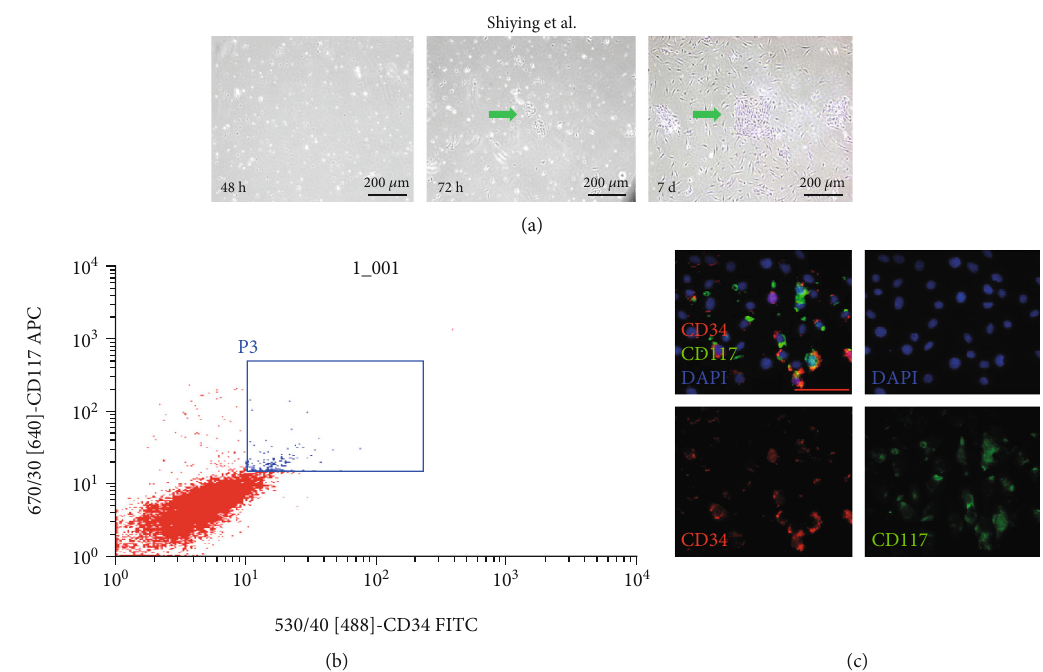
Figure 4: Isolation and cultivation of CD34 + CD117 + HGSV-AdPC in vitro . (a) Cells of HGSV wall obtained by collagenase II digestion at 48 hours, 72 hours, and 7 days culture. The green arrow indicates cells growing in colony. (b) FACS isolation of CD34 + CD117 + HGSV-AdPC; the double positive cells were about ( 1 : 2 ± 0 : 07 )% in vein wall cells. (c) Immuno fl uorescent staining with antibodies CD34 (red), CD117 (green), and DAPI (blue) of the FACS-puri fi ed HGSV-AdPC after 7 days culture, and the double-positive cells accounted for 91.2%. Scale